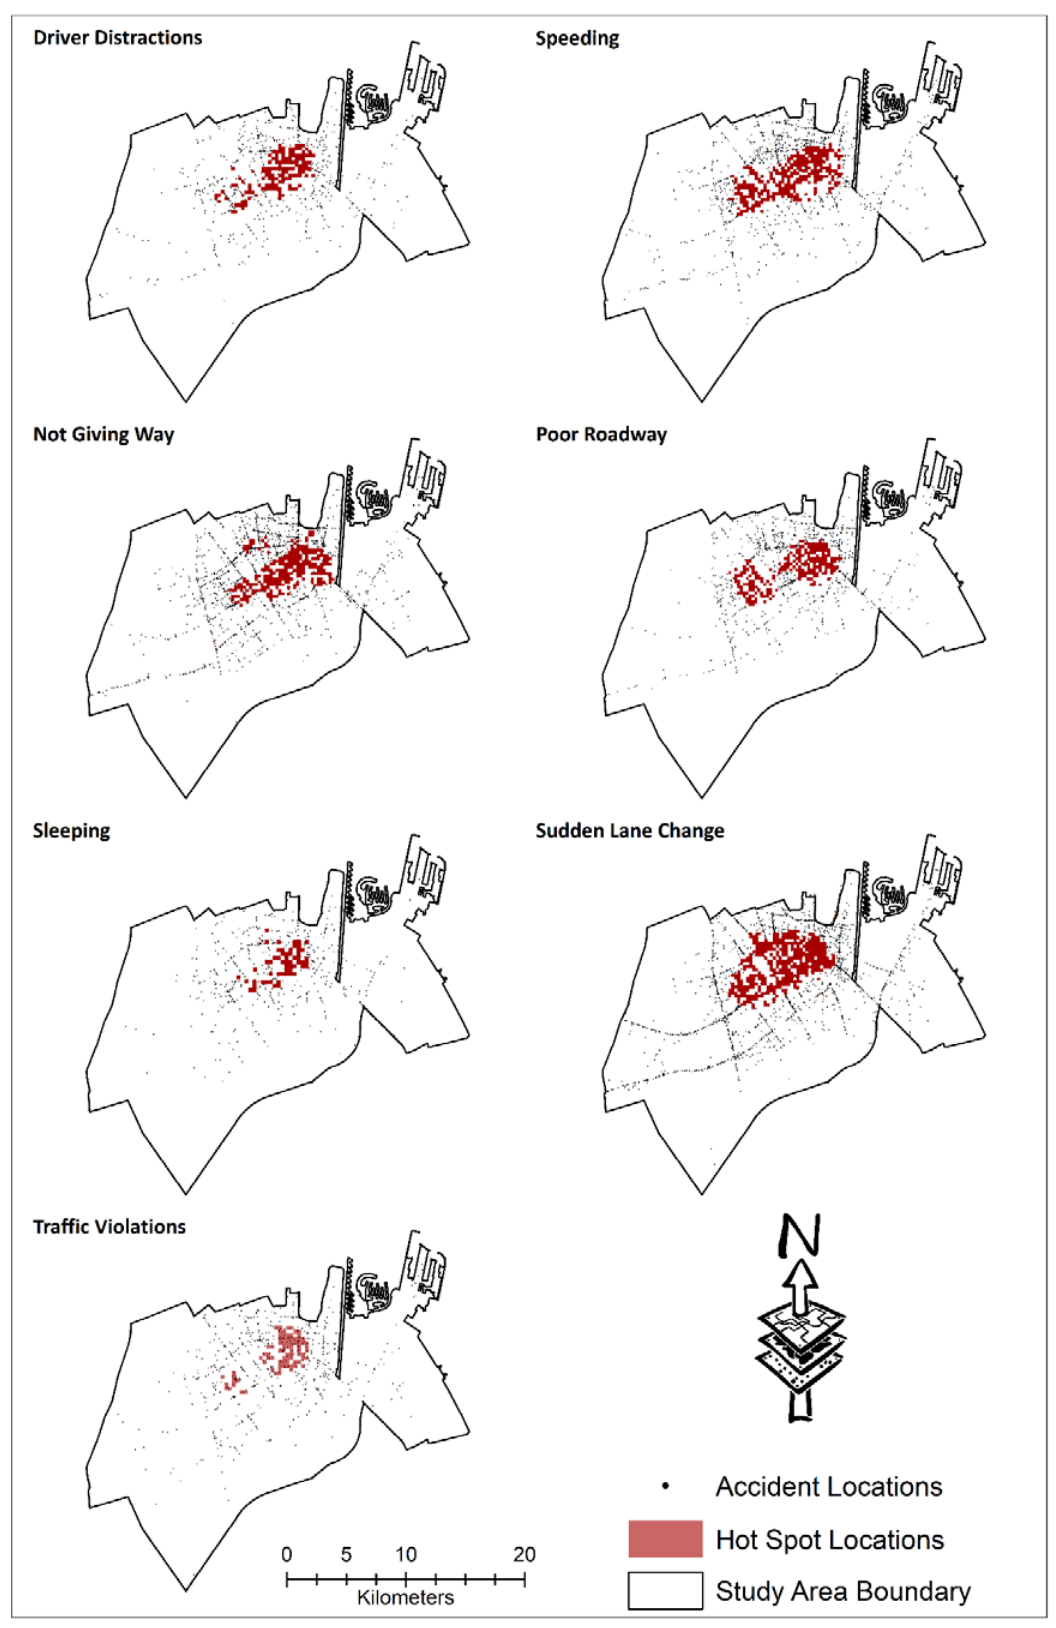
Figure 5. Distribution of hotspots by crash causes.